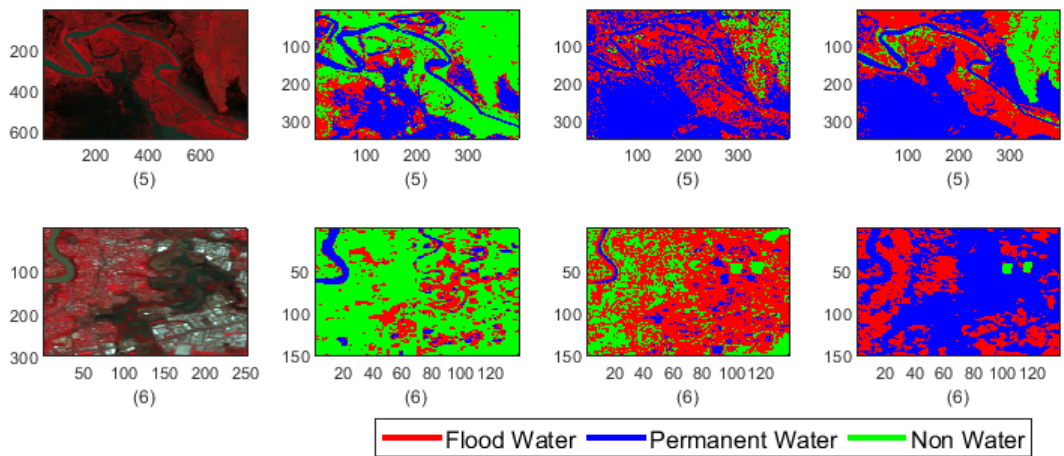
Figure 9. Classification results of F-CNNs and SVM classification models. Cells-( A1 – A6 ) showing the original Landsat test images. Cells-( B1 – B6 ) showing the labelled images from the reference data. Cells-( C1 – C6 ) showing the classification results of context-based F-CNNs model. Cells-( D1 – D6 ) showing the classification results of pixel-based SVM model.